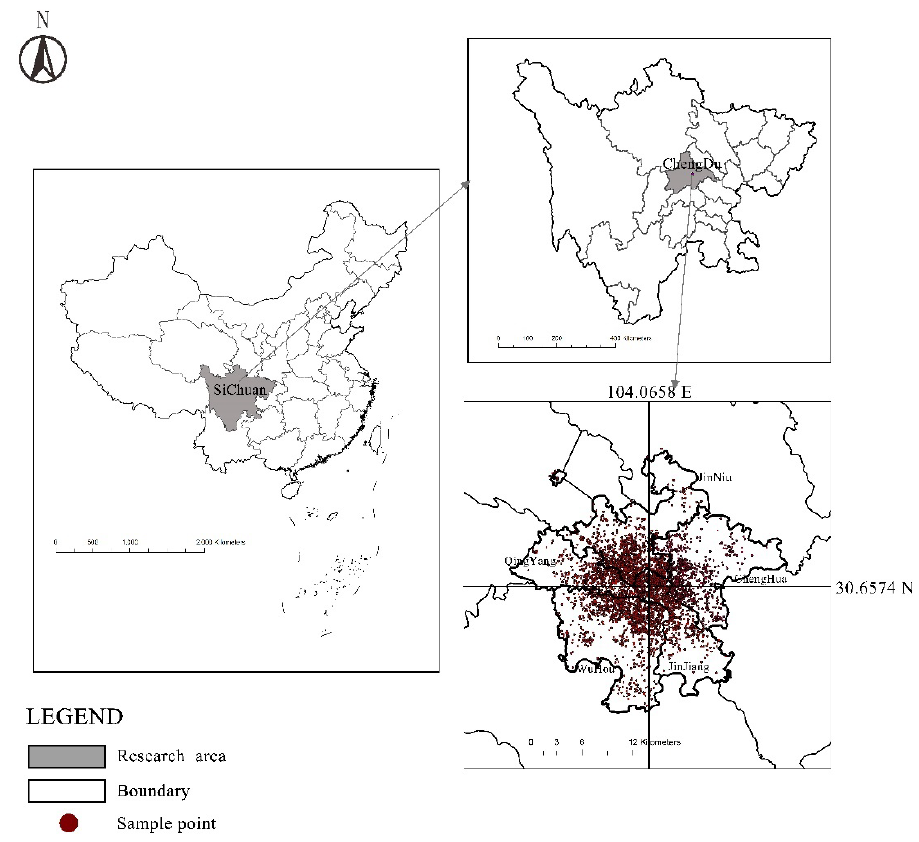
Figure 2. Location of the study area.